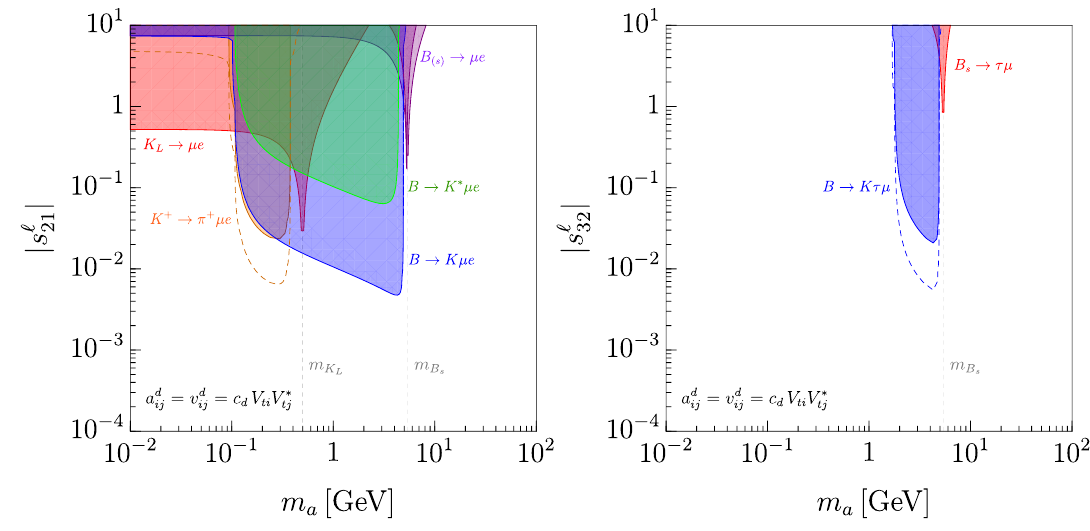
(left panel) and s ‘ (right panel) as a function of the ALP mass s ‘ 21 j 32 j j j = v d c d V ti V (cid:3) , with c d 10 (cid:0) 2 , has been ij ij ’ tj (cid:25)